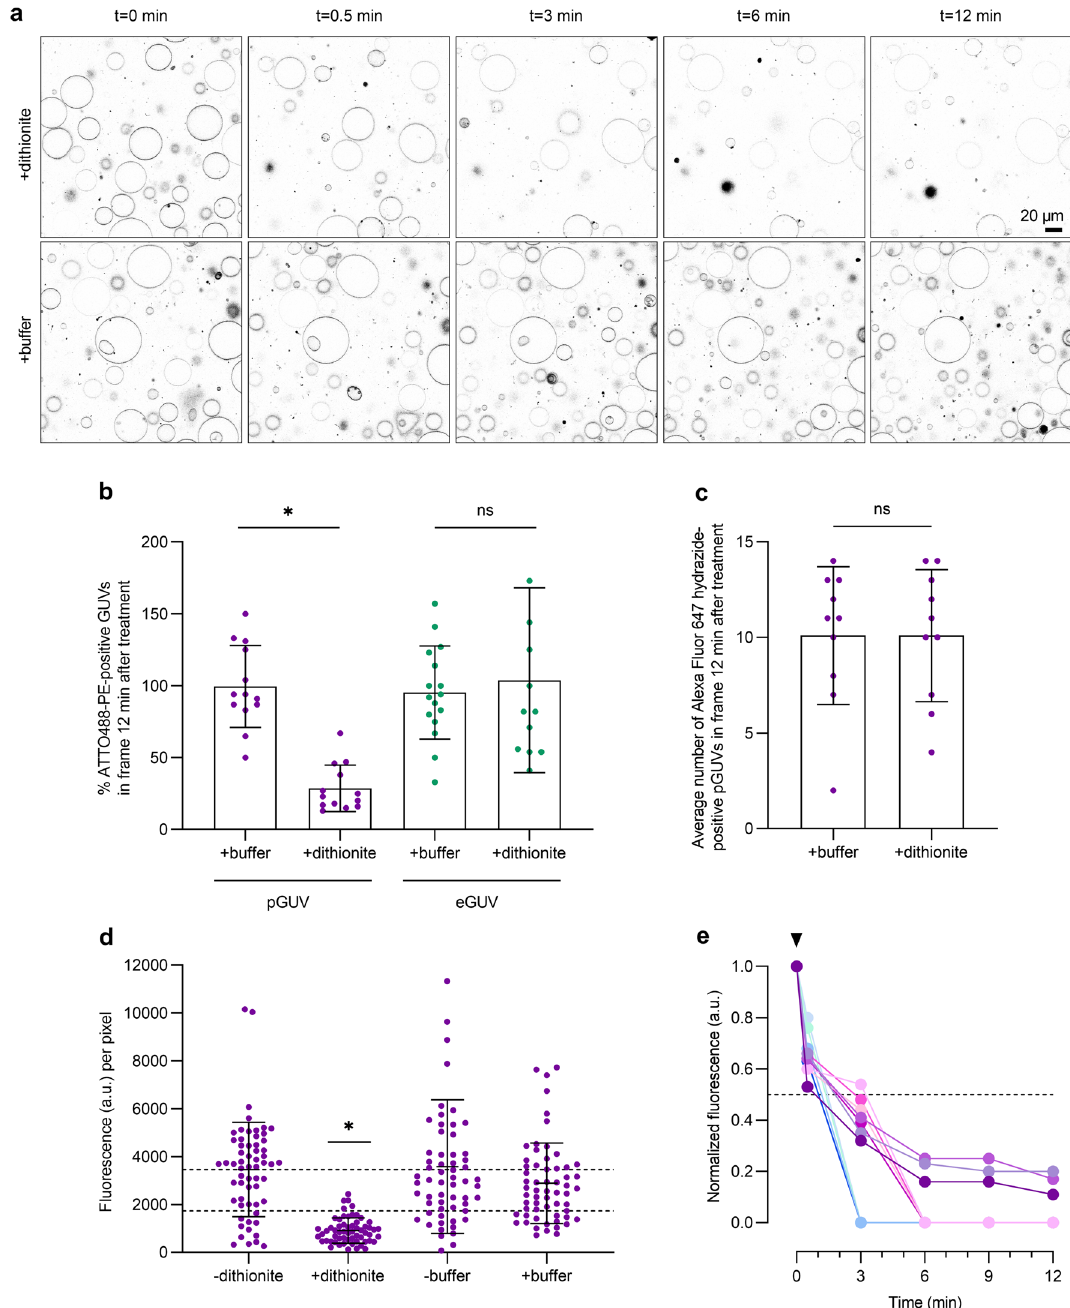
Figure 6. Dithionite bleaching of ATTO488-PE in pGUVs. ( a ) Confocal time series of ATTO488-PE- containing pGUVs before (t = 0 min) and after (t = 0.5, 3, 6, 12 min) addition of dithionite or buffer. ( b ) Dot plot showing the percentage of ATTO488-PE-positive pGUVs and eGUVs in more than ten fields of view at t = 12 min, compared with the value at t = 0 min in the same field. ( c ) Dot plot showing the average number per imaged field of Alexa Fluor 647 hydrazine (lumenal marker)-positive pGUVs and eGUVs after 12 min treatment with dithionite or buffer. ( d ) Dot plot of ATTO488-PE fluorescence of individual pGUVs within the field of view before (-) and 12 min after ( +) treatment with dithionite or buffer alone (purple dots, n = 60). Black lines indicate mean ± s.d. (one-way ANOVA and Tukey test, *P < 0.0001). Dashed lines are provided as a guide to indicate 100% and 50% levels of fluorescence based on the mean value at t = 0 min. ( e ) Dithionite reduction of ATTO488-PE fluorescence of eleven individually tracked pGUVs (coded in different colors), normalized to the fluorescence value at t = 0 min. The arrowhead indicates dithionite addition. The horizontal dashed line corresponds to 50% loss of fluorescence. Four of the traces show complete loss of fluorescence by t = 3 min, four show complete loss of fluorescence by t = 6 min, and three show detectable fluorescence at t = 12